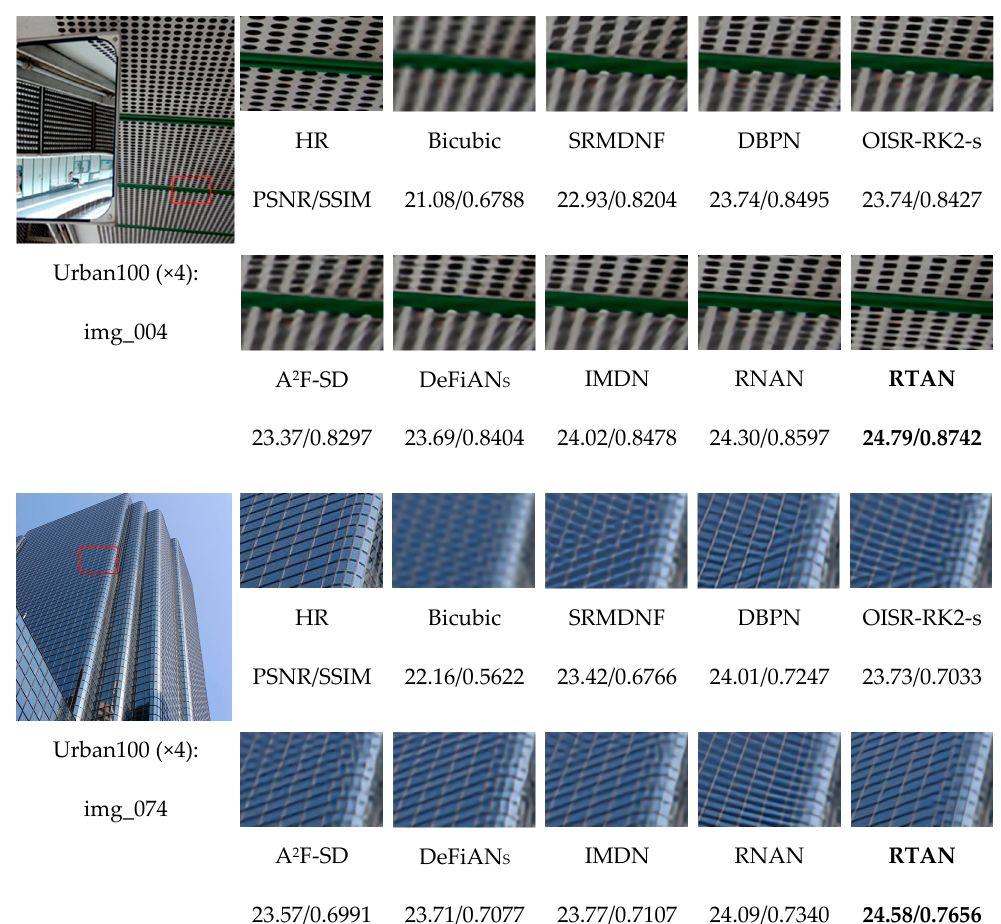
Figure 4. The visual comparison of × 4 SR with BI model on Urban100 dataset. The best results are highlighted.